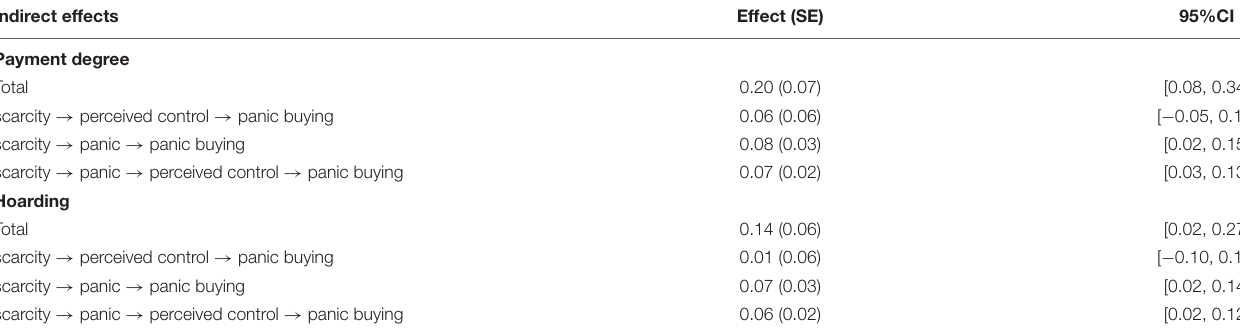
TABLE 6 | Summary of indirect effects in study